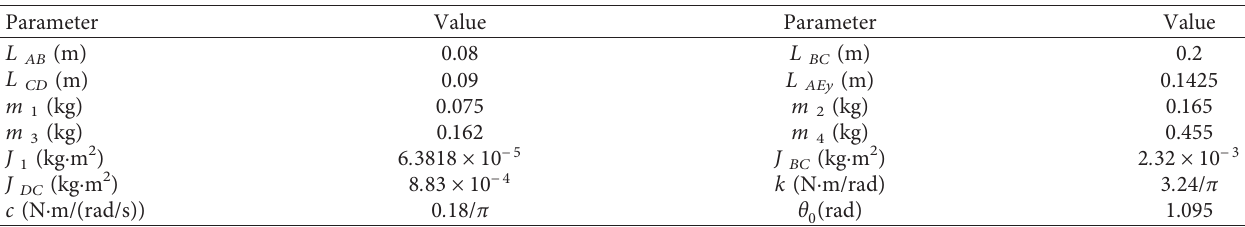
Figure 11: The schematic diagram of the planar double-folded metamorphic mechanism. Table 2: Geometric and inertia parameters of the planar double-folded metamorphic